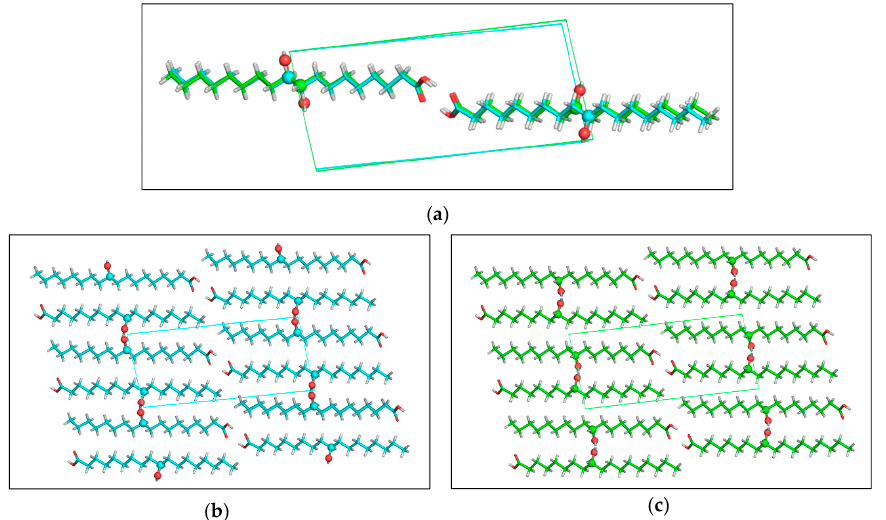
Figure 9. Comparison between the structures of ( R )-10-HSA and ( R )-9-HSA crystallized from polar